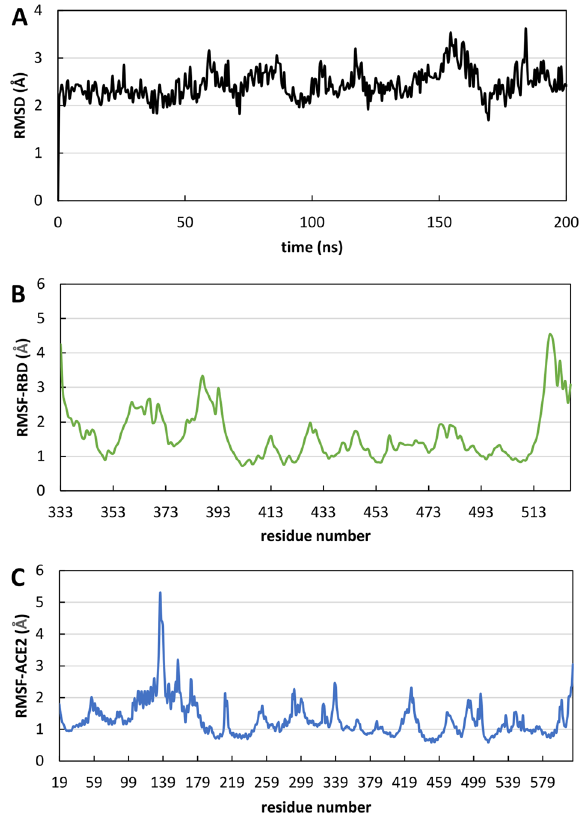
Figure 4. Evolution of structural properties over time. ( A ) Cα-RMSD as a function of time of Delta RBD-ACE2 complex. ( B ) RMSF of Delta RBD as a function of amino acids. ( C ) RMSF of ACE2 as a function of amino